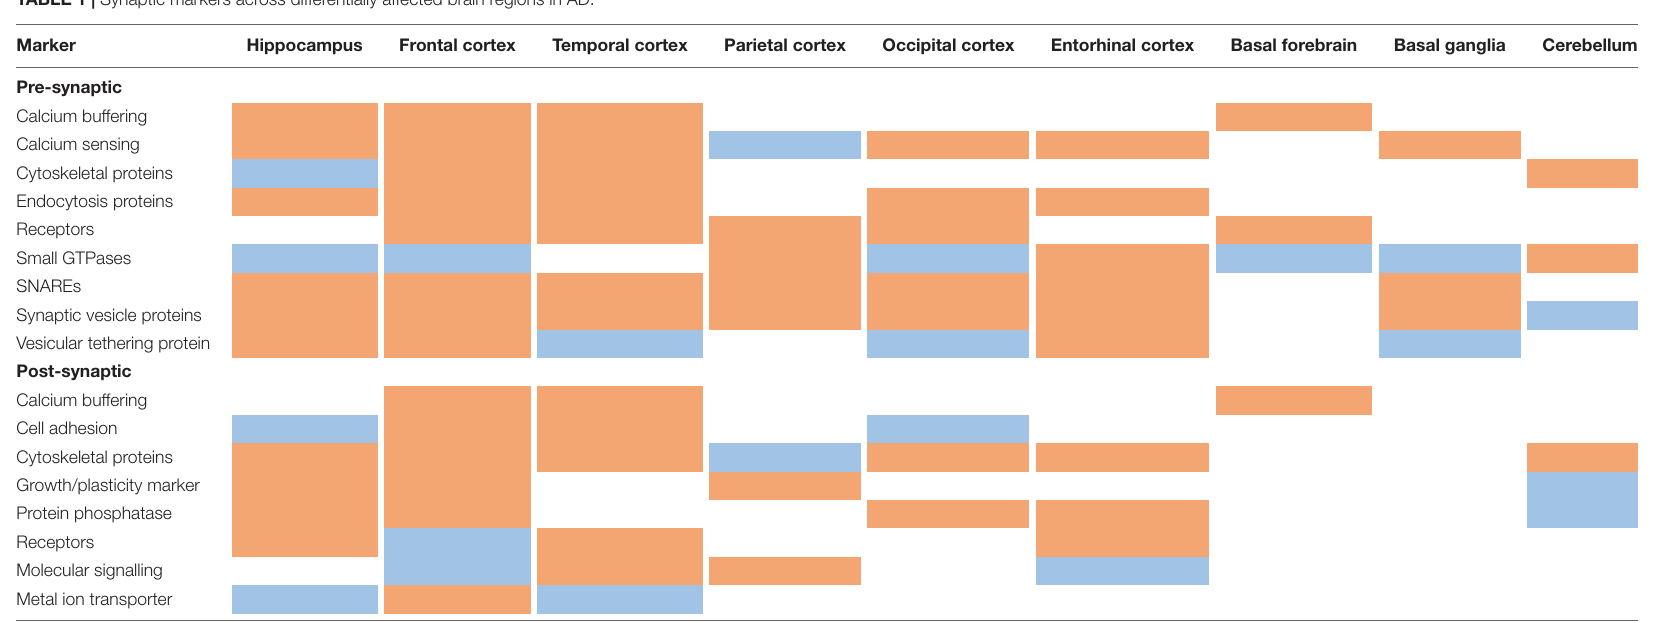
Red shading indicates downregulation and blue indicates upregulation in AD; refer to the text for example